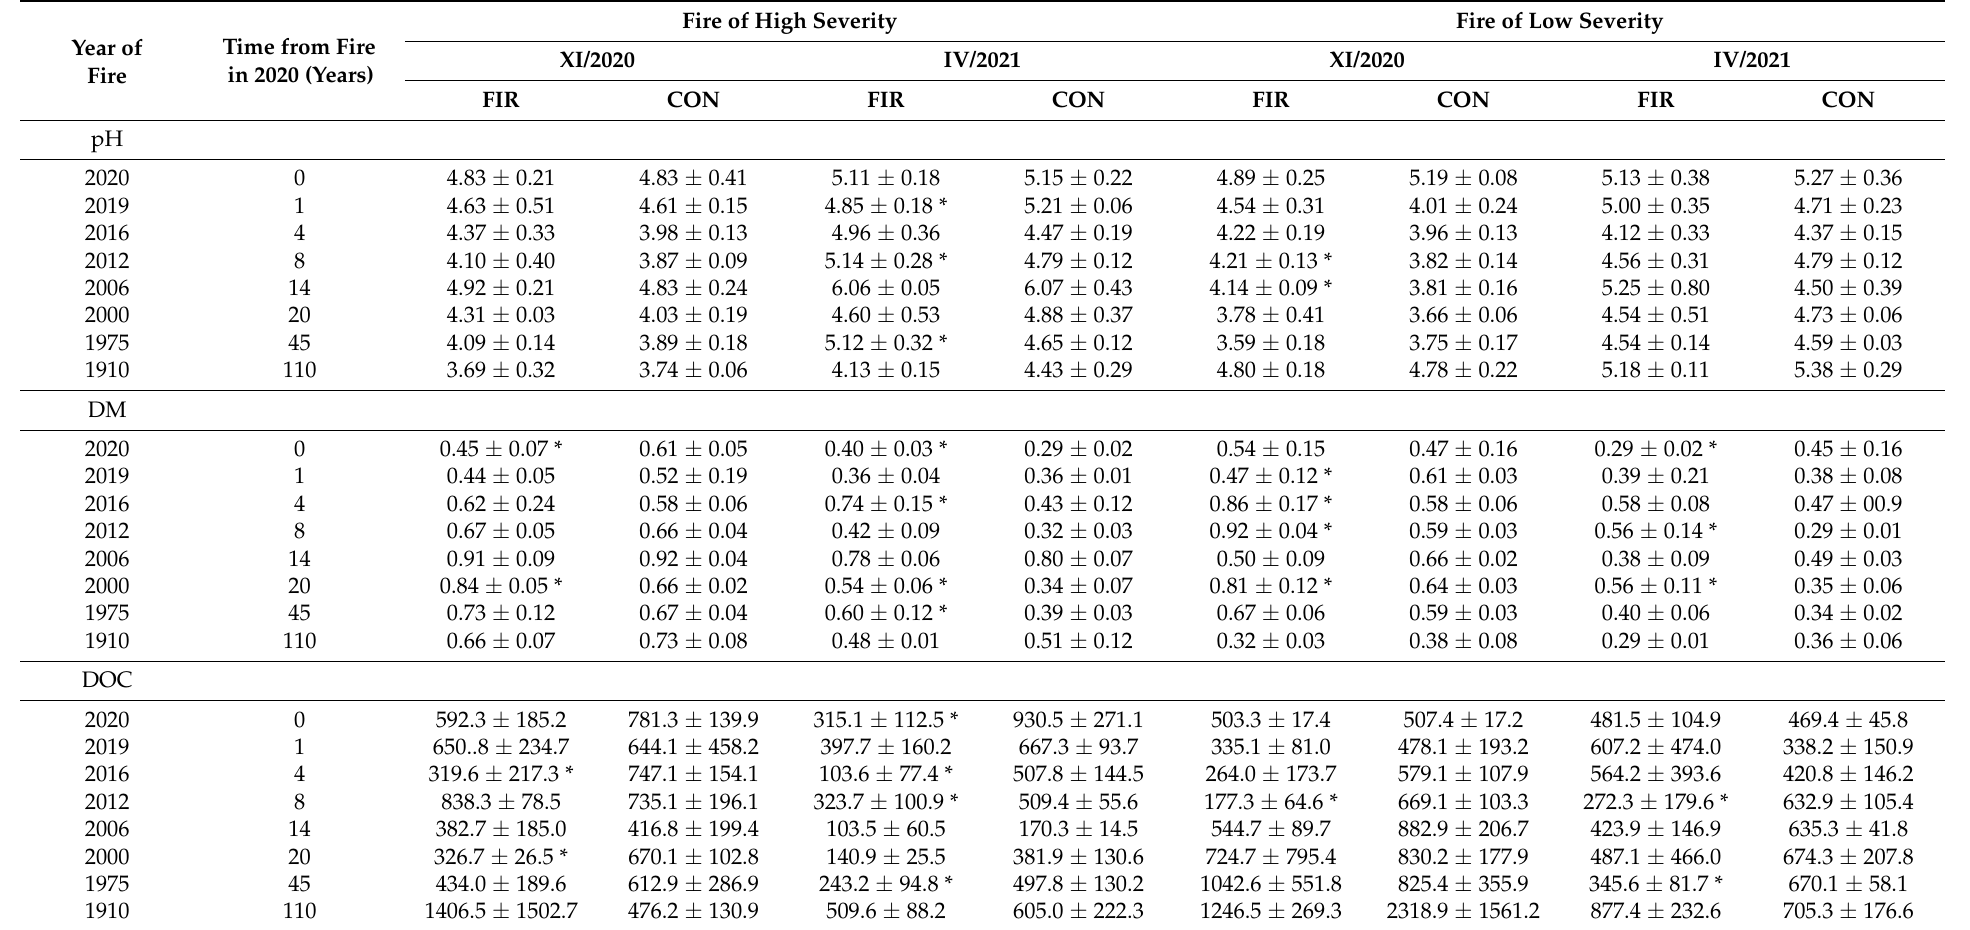
Table 2. Mean values ( ± S.D, n = 3) of physicochemical soil properties in high and low severe fires (FIR) and related control (CON) sites in September 2020 and April